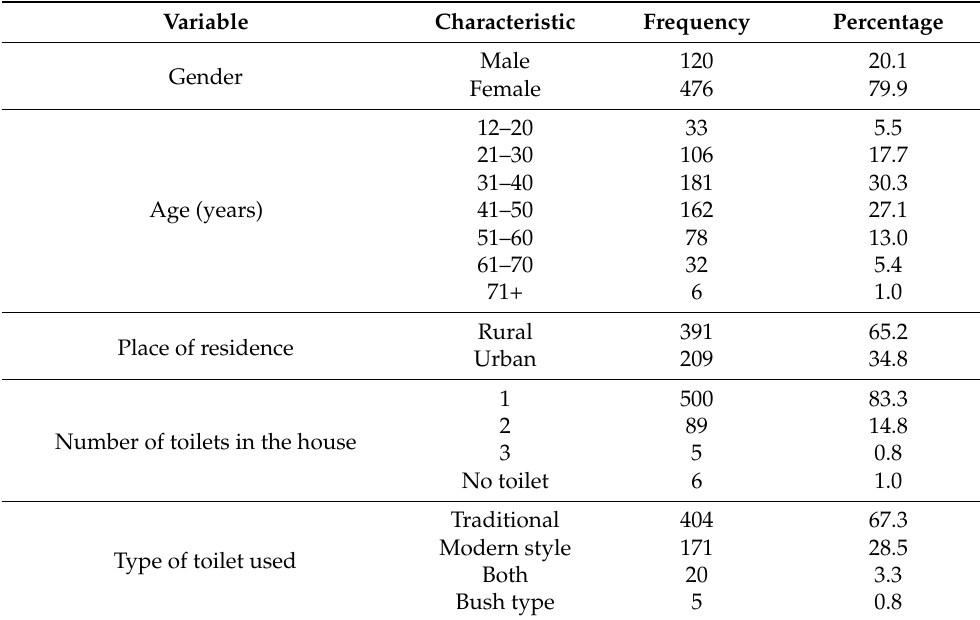
Table 1. Sociodemographic characteristics of all research participants at the four selected sites in the Eastern Cape ( n =